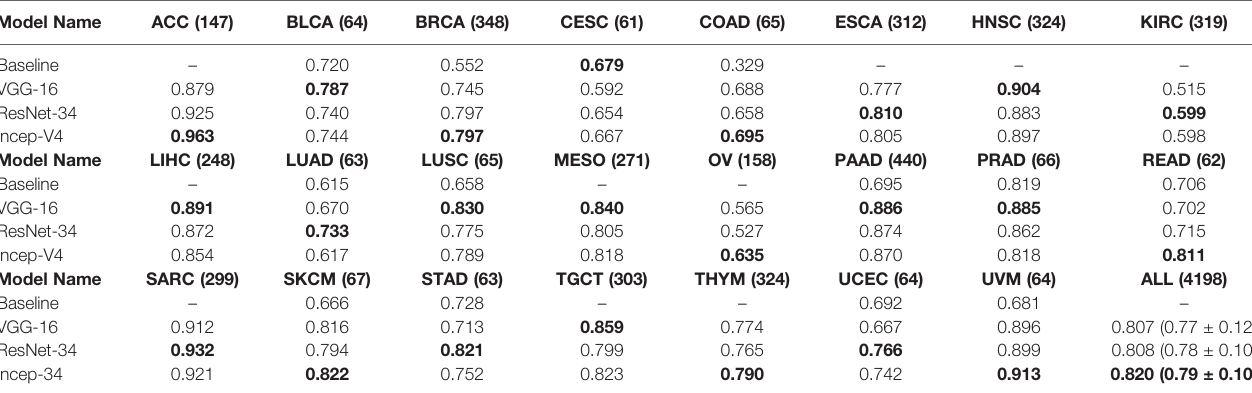
TABLE 3 | Superpatches evaluation using polyserial correlation coef fi